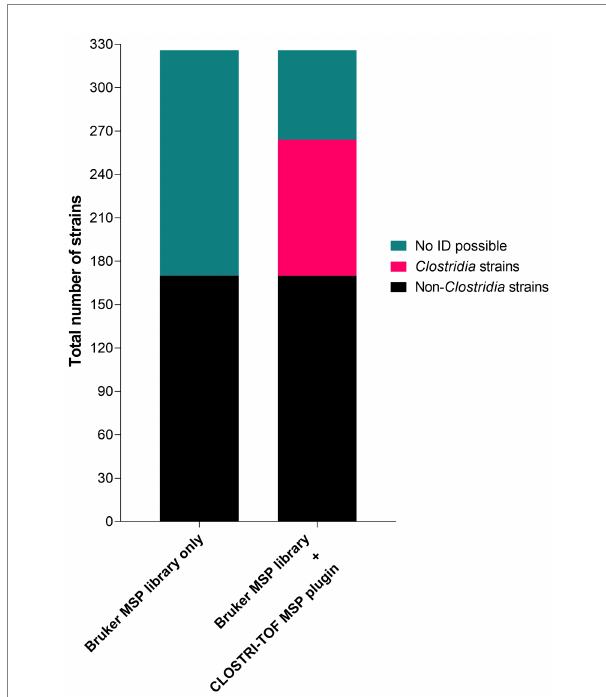
FIGURE 5 Identification rates for 326 bacteria isolates tested using the Bruker- Daltonics MALDI Biotyper Compass MSP library v. 4.1.100 combined or not with the CLOSTRI-TOF database